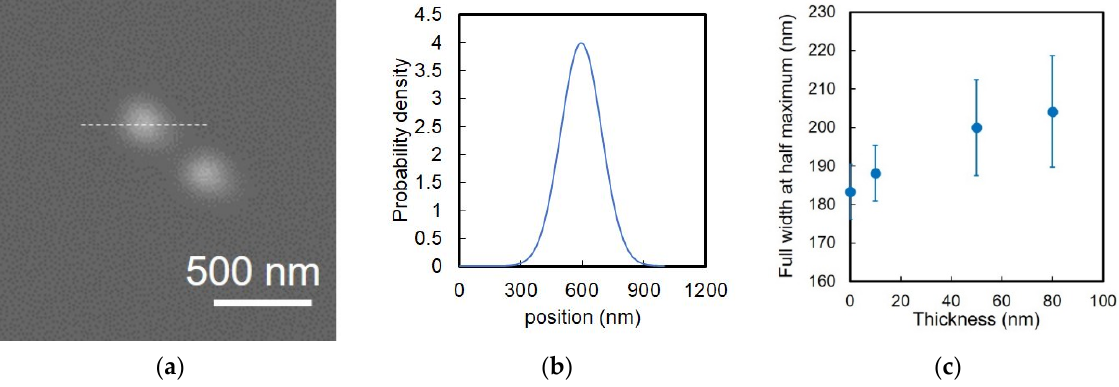
Figure 7. Full width at half maximum of gold nanoparticles of 200 nm in diameter. ( a ) SEM image of gold nanoparticles. ( b ) Brightness distribution along white dash line over a gold nanoparticle in ( a ). ( c ) Full width at half maximum of gold nanoparticles as a function of thickness. Error bar was standard deviation of diameter of three gold nanoparticles.